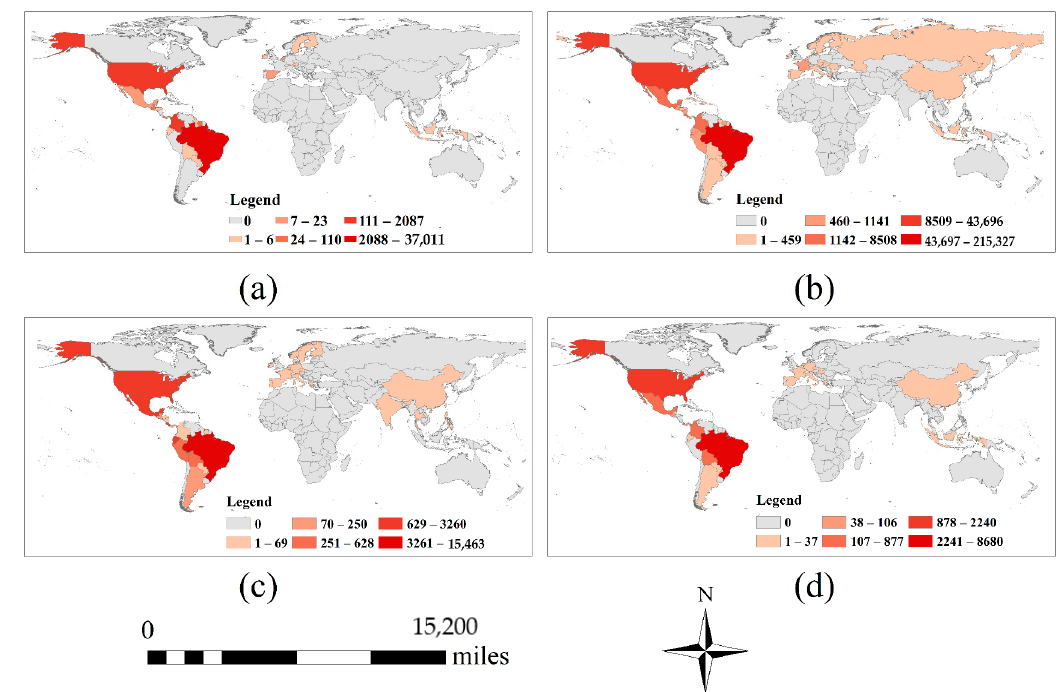
Figure 2. The spatial distribution of ZIKV from 2015 to 2018. The sub-graph ( a – d ) represent 2015, 2016, 2017 and 2018 respectively. The base map does not include Antarctica, as no cases have been reported there.